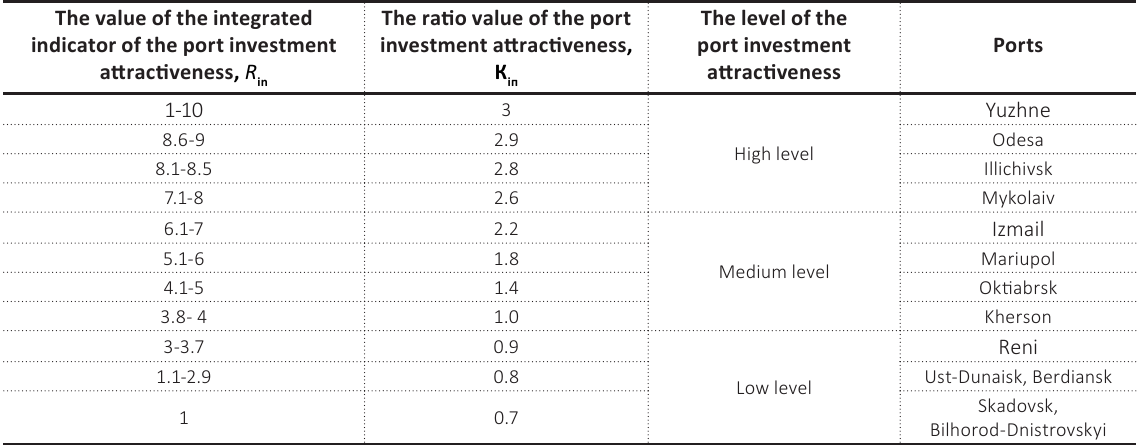
Source: Developed by the